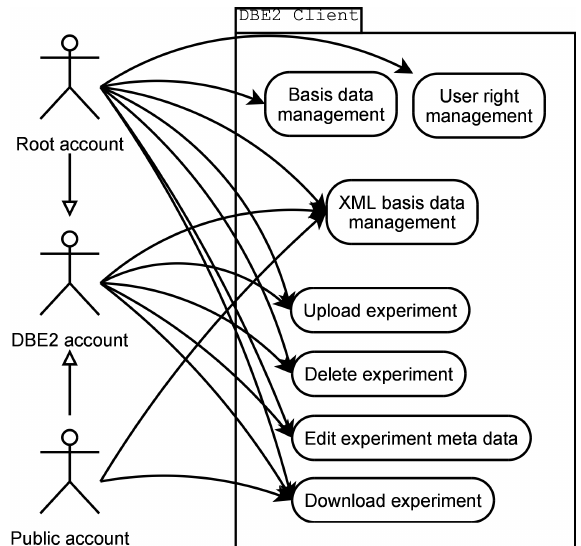
Figure 4: Use cases diagram of the DBE2 client . There are three types of accounts. The special (i) public account may used by everybody and is allowed to download particular experiments and to edit the basis data in the local XML representation of experiments. Users with a (ii) regular DBE2 account may upload, download, and edit experiments in addition. The DBE2 administrator uses the (iii) root account and is thus allowed to access all features including the management of DBE2 database basis data and the appointment of user